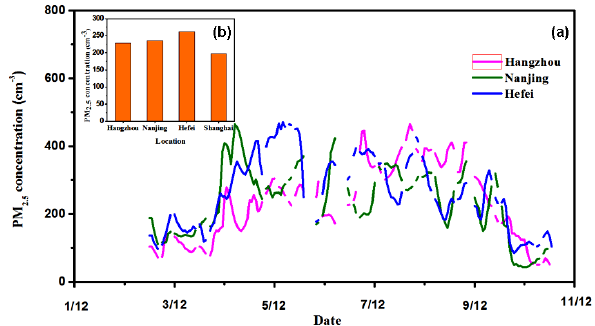
Figure 2. Temporal variations of PM 2 . 5 in Hangzhou, Nanjing and Hefei (a) and their mean concentrations from 1 to 10 Decem- ber